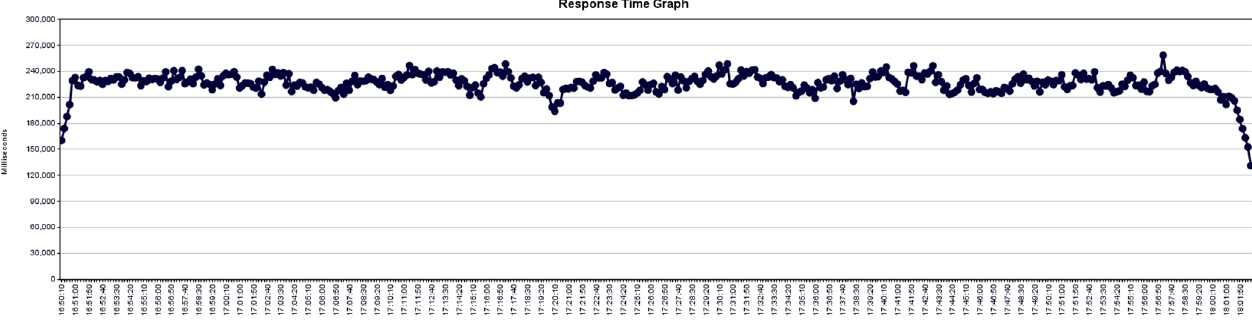
Figure 10. Efficiency performance comparison of proposed algorithms.